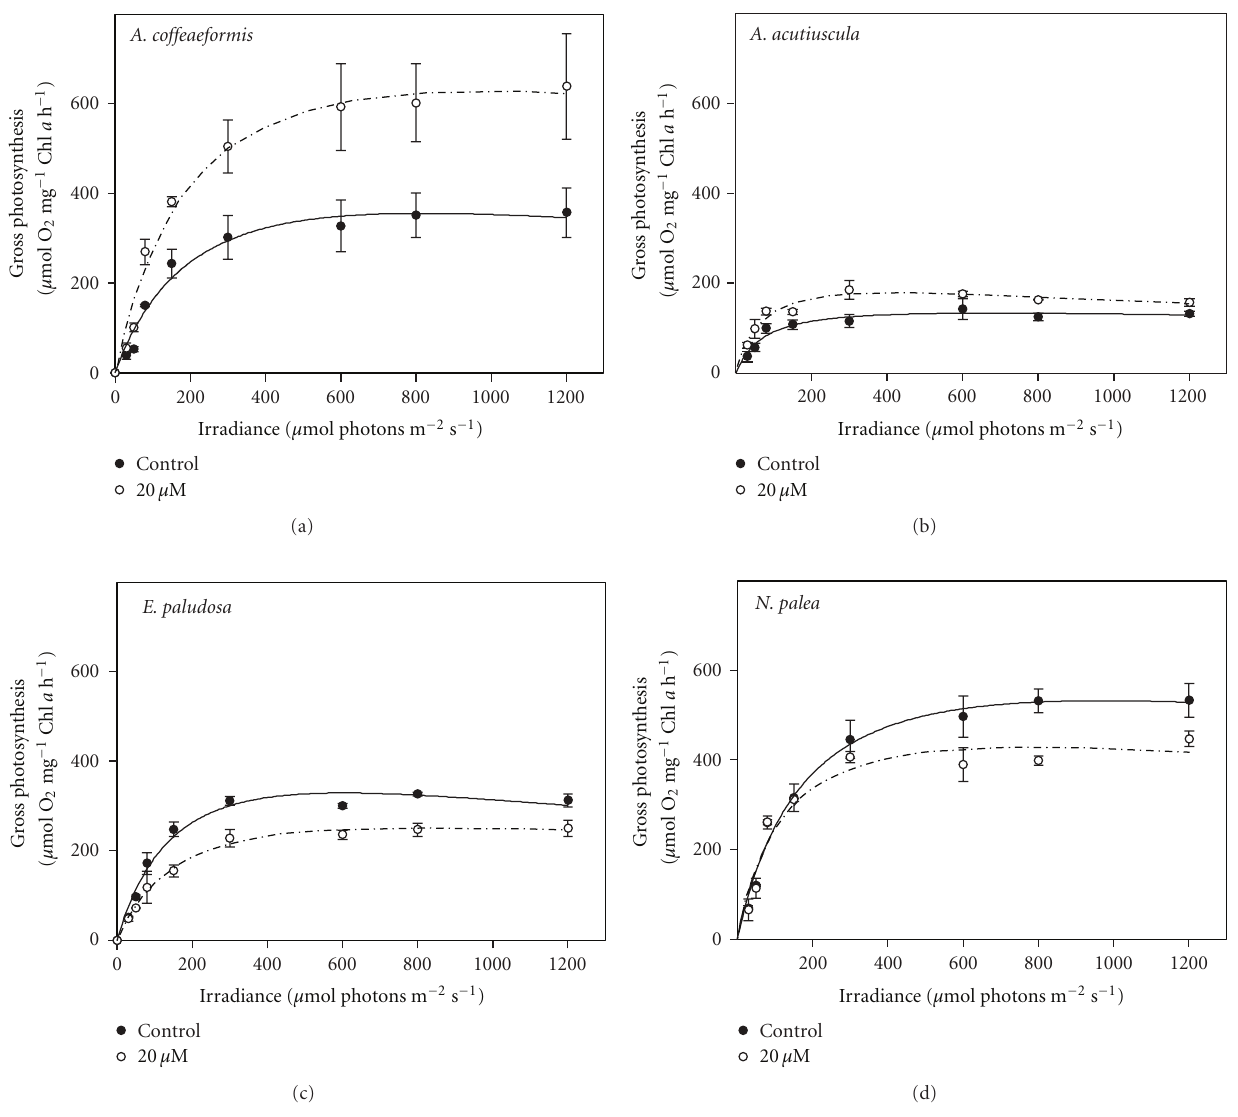
Figure 1: Gross photosynthesis versus irradiance curves in Amphora co ff eaeformis , Amphora acutiuscula, Entomoneis paludosa, and Nitzschia palea grown in ASW (control) or in the presence of 20 μ M Zn added to ASW. Mean values ± SE ( n = 3–5).